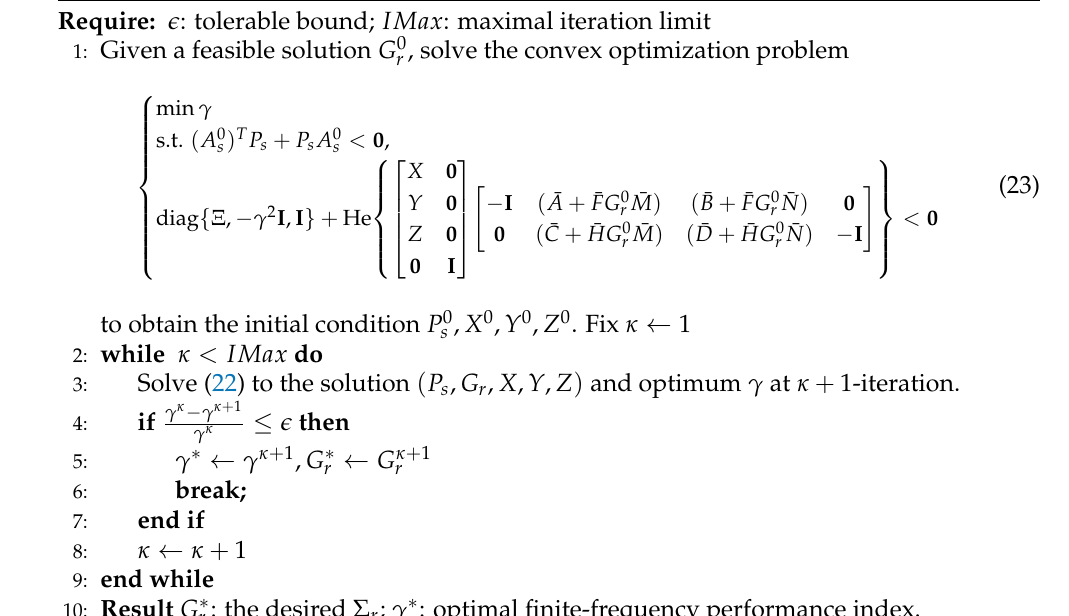
Algorithm 1 SCO algorithm for calculating reduced-order